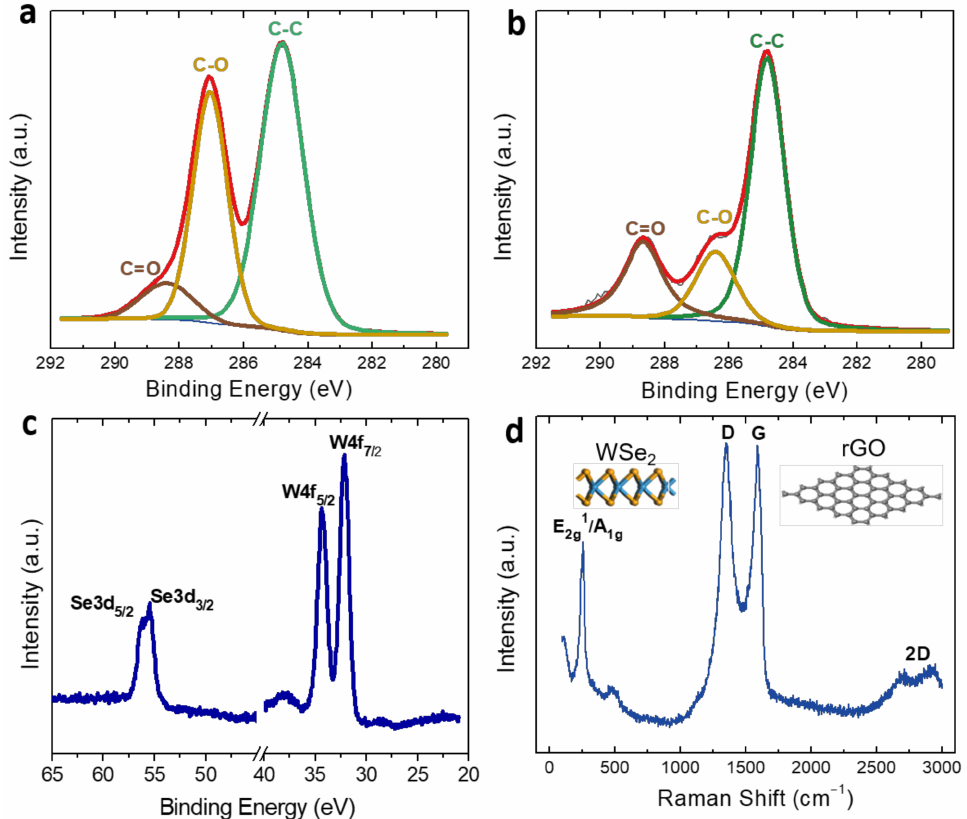
Figure 2. XPS C 1s spectrum of ( a ) GO and ( b ) rGO. ( c ) XPS spectra of W 4f and Se 3d of WSe 2 . ( d ) Raman spectrum of rGO/WSe 2 sensitive